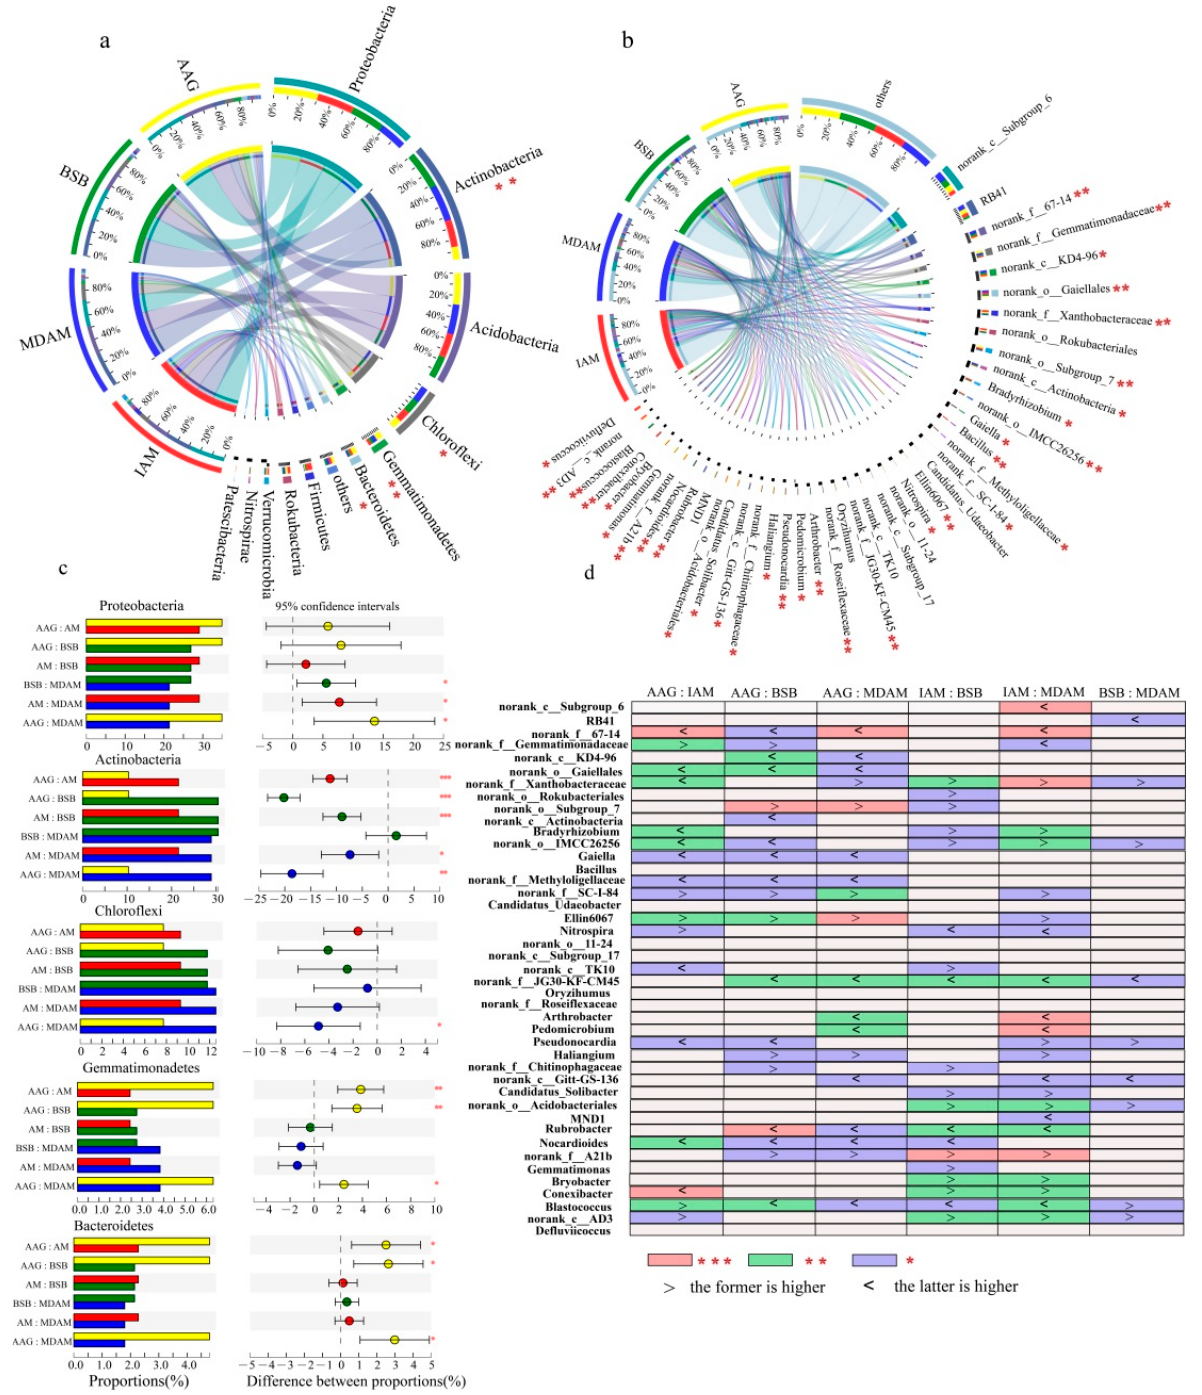
Figure 3. The relative abundance of the dominant bacterial ( a , b ) at the phyla and genus level and their composition variations ( c , d ) in alpine meadows with different groups. Phyla or genera with a relative abundance of less than 0.01 in all samples were classified as others. *** <0.001; ** <0.01; * <0.05. IAM, intact alpine meadow; MDAM, oderately degraded alpine meadow; BSB, black soil beach; AAG, artificial grassland.